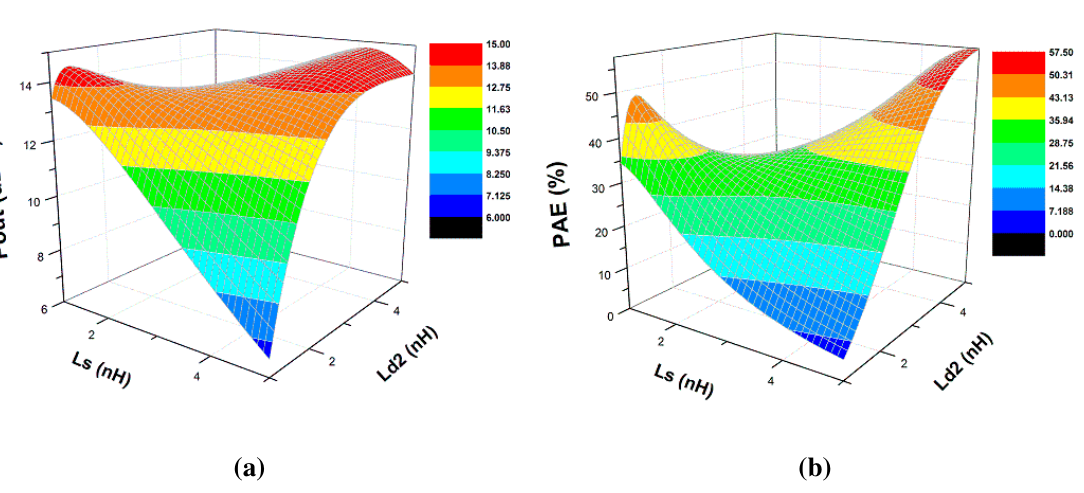
Figure 18. ( a ) Output power versus L and L . d 2